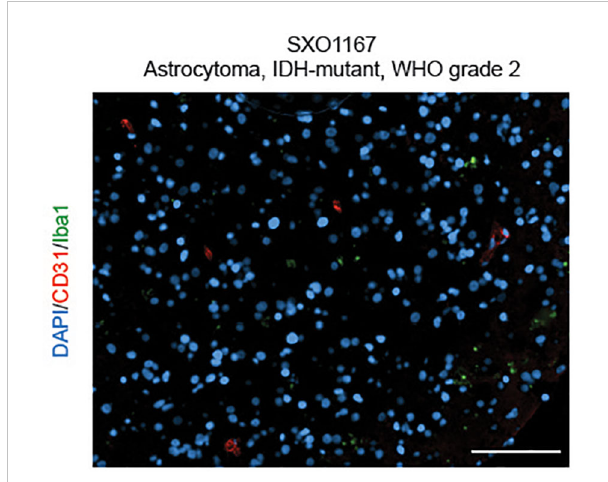
FIGURE 1 Surgically eXplanted Organoid from an astrocytoma, IDH-mutant, WHO Grade 2 (SXO1167). Organoids were cultured for 4 weeks, then cryopreserved, reanimated, and cultured for one week prior to analysis. Organoid was evaluated by CD31/Iba1 IF. Red = CD31, blue = DAPI, and green = Iba1. Scale bar = 100